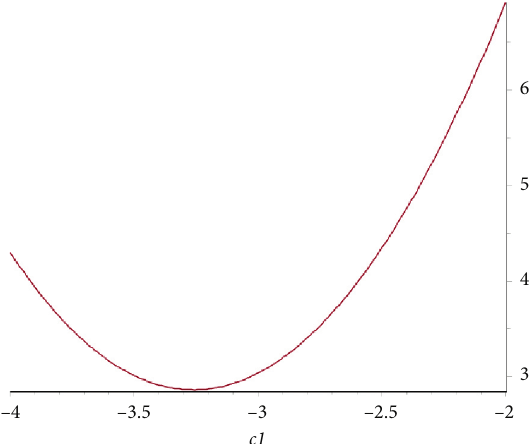
Figure 13: The graph of the function G 100.